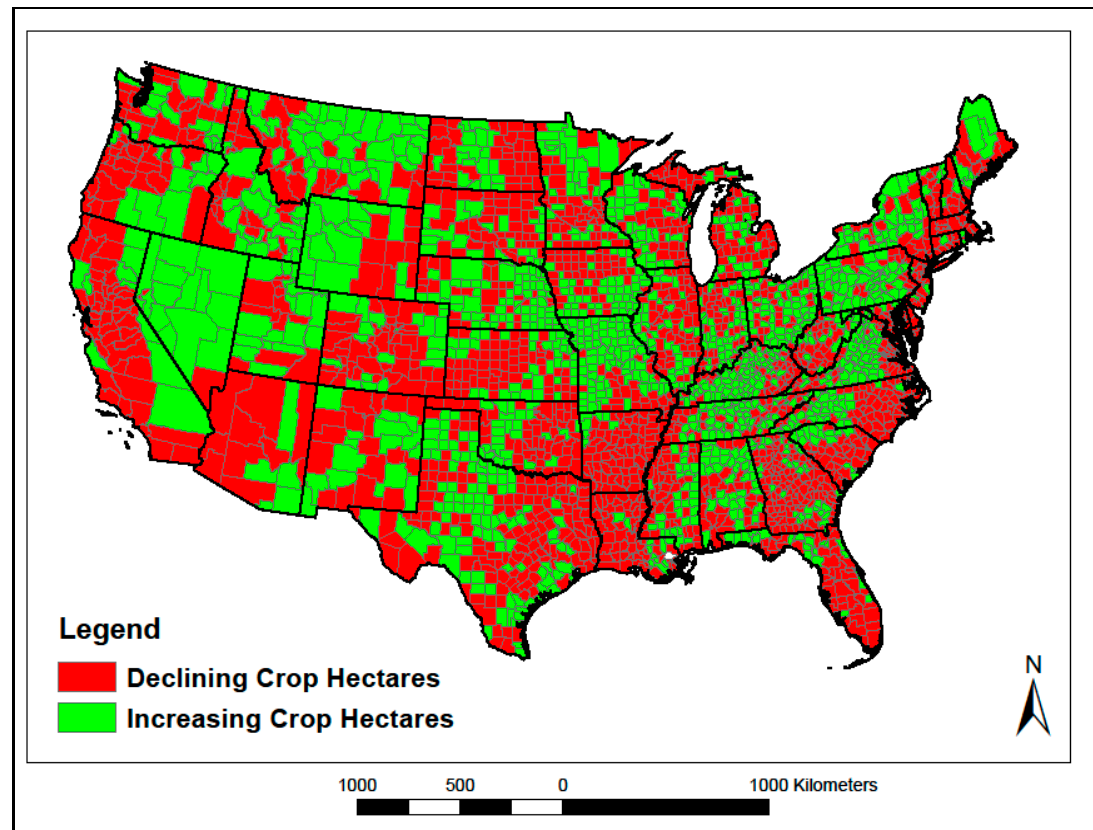
Figure 6. Counties with Increasing and Declining Crop Area from 2008 to 2020. Map by author.